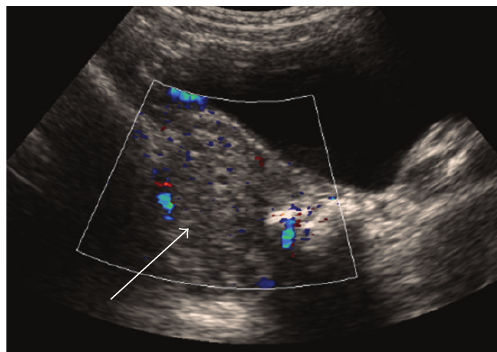
Figure 2: Doppler ultrasound of a large right ovarian cyst (estimated ovarian volume of 41cm 3 ) demonstrating arterial flow but scant venous